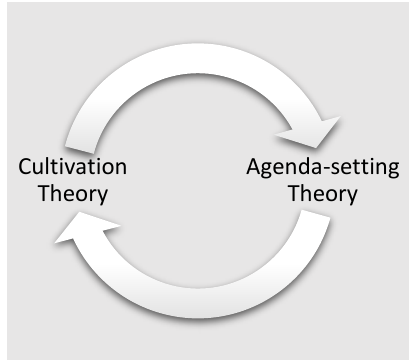
Figure 1. The accumulative agenda effect model of cultivation theory and agenda-setting theory.